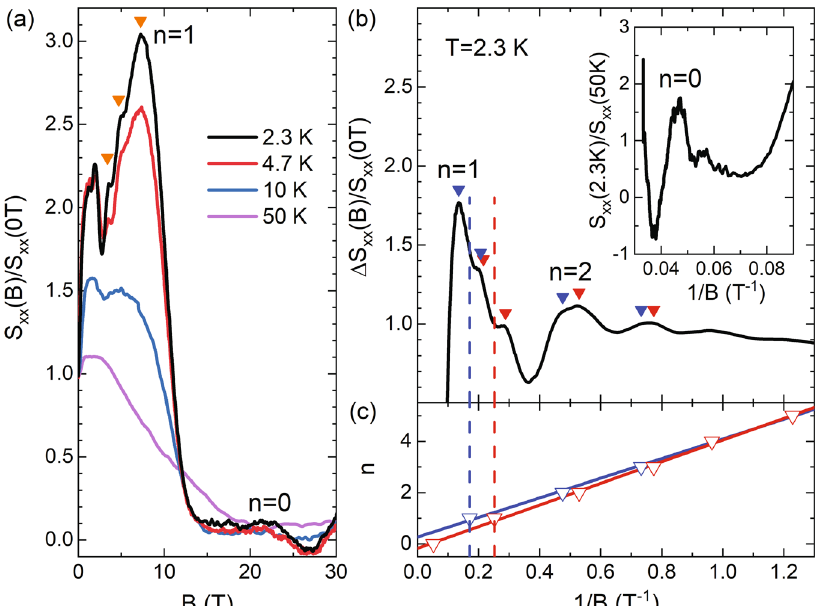
Fig. 3 Magneto-thermopower measurements in ZrTe 5 . a Normalized magneto-thermopower, S xx ( B )/ S xx (0T), measured at different temperatures. The three orange down-triangles indicate the splitting of the n = 1 peak. b Oscillatory component Δ S xx as a function of 1/ B at 2.3 K, obtained by subtracting a linear background from S xx . Inset: The n = 0 peak obtained by reference to the high-temperature data at 50 K, S xx (2.3 K)/ S xx (50 K). c Landau fan diagram of the magneto-thermopower oscillations at 2.3 K. The peak features in b are separated into two groups depending on the splitting mechanism and labeled by the red and blue down-triangles, respectively. The dash lines indicate the average positions of additional splittings in the n = 1 LL, and the solid lines are linear fi ts to the data of each group.